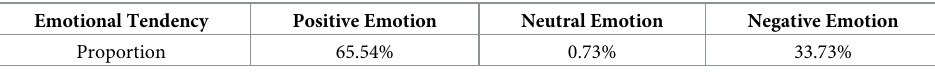
Table 5. The general emotional tendencies in traditional settlement culture landscape